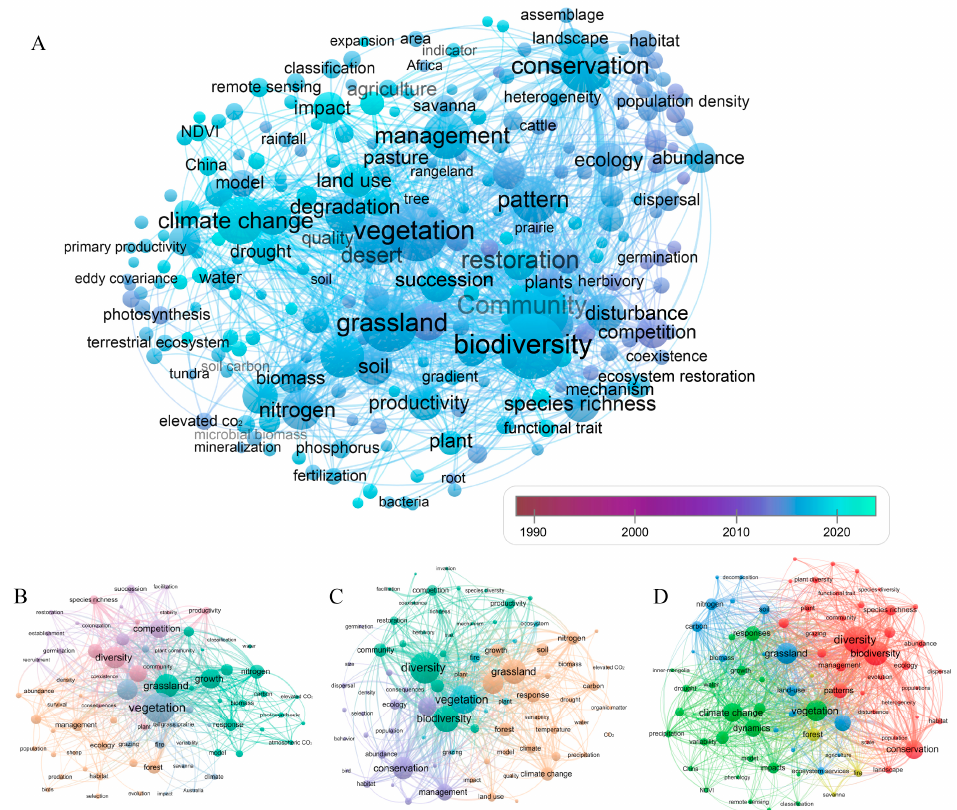
Figure 5. Keyword hotspot evolution of grassland ecosystems. Subfigure ( A ) showed keywords occurrences from 1990 to 2021; Subfigure ( B ) showed keywords occurrences from 1990 to 2005; Subfigure ( C ) showed keywords occurrences from 2006 to 2015; Subfigure ( D ) showed keywords occurrences from 2016 to 2021. (Every node in the network represented a keyword, the size of nodes by occurrences, and the link between the nodes represented the keywords co-occurrence. Only keywords that met the threshold that minimum number of occurrences > 170 were included in the study).